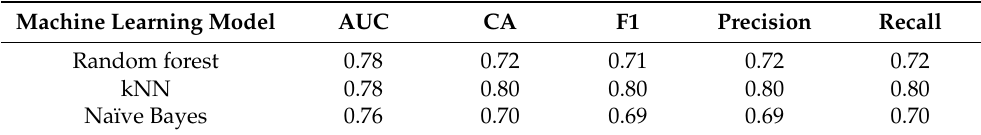
Table 2. The performance metrics for the classification of renal cell carcinoma and control group patients based on surface-enhanced Raman spectroscopy (SERS) spectra of serum using three classification algorithms (random forest, kNN, and naïve Bayes). AUC—area under the curve; CA— classification accuracy; F1—score represents the harmonic mean of precision and recall; Precision—positive predicted values; Recall—sensitivity. Machine Learning Model AUC CA Precision Random